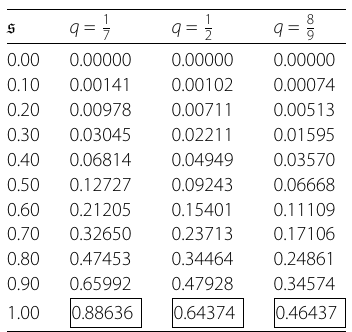
(cid:13) s ( s – q ` ι ) ( ν –1) (cid:11) q ( ν ) 0